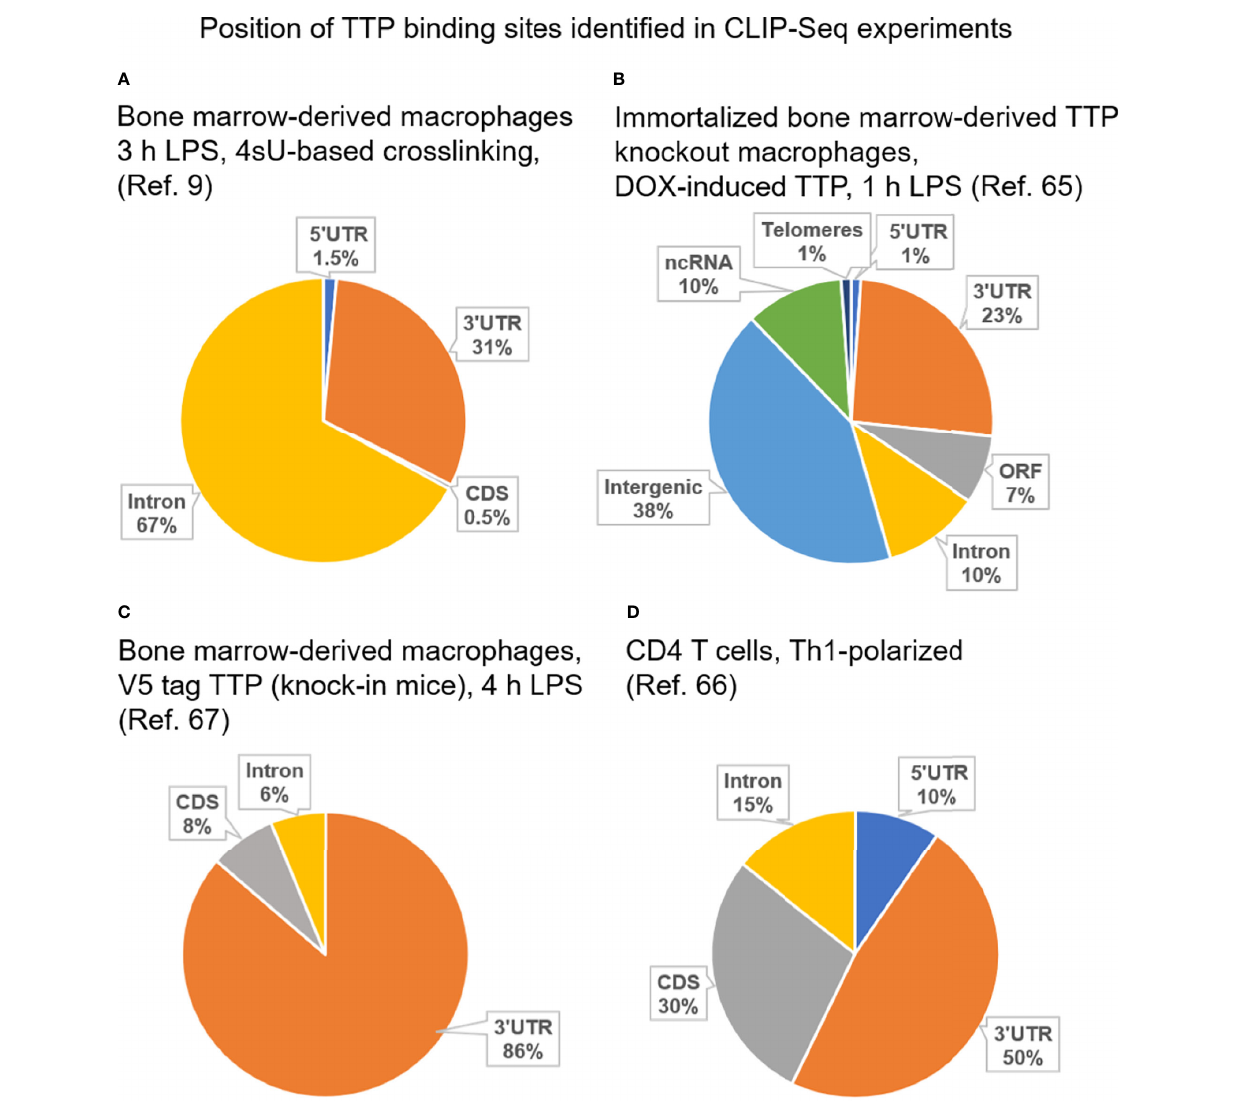
ncRNA, non-coding RNA; DOX,